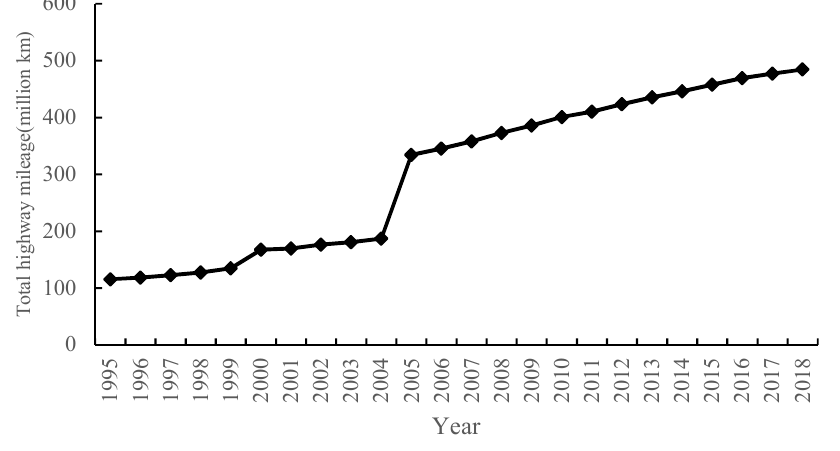
Figure 2. Highway mileage change trend. Table 3. Descriptive statistics of the data.